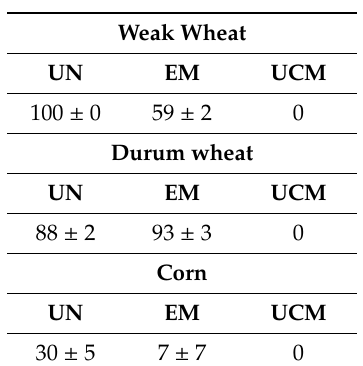
Table 2. Germination percentage ( ± SD) for UN, EM, and UCM samples of weak wheat, durum wheat, and